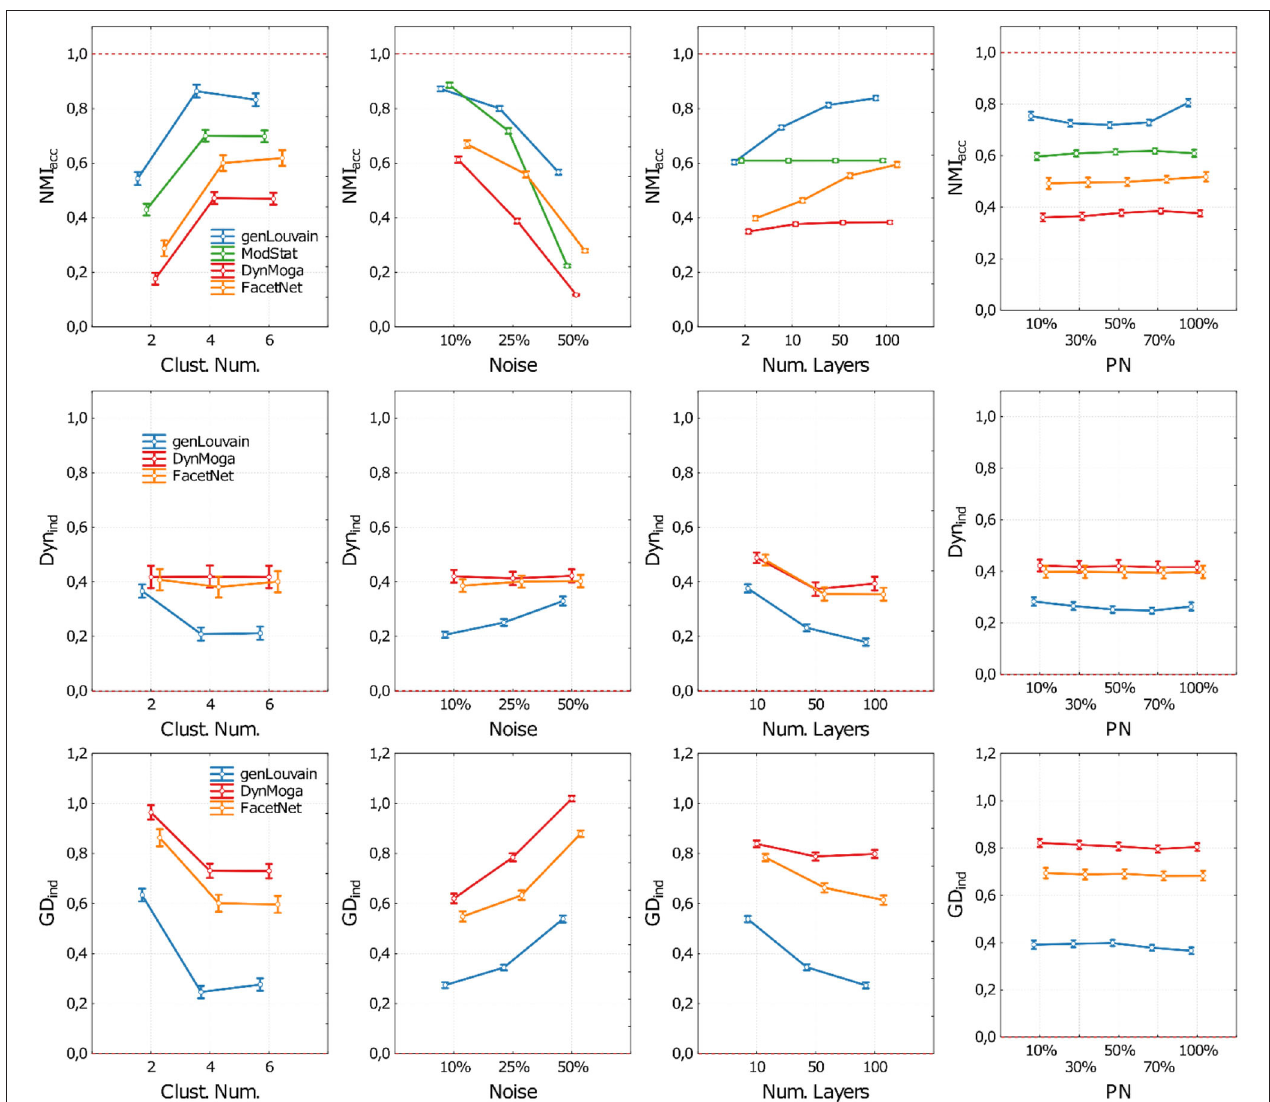
FIGURE 4 | Plot of means and standard deviations of the three indices used to execute the comparative analysis on networks with evolving community structure. Each row of the figure corresponds to one index (NMI acc , Dyn ind , and GD ind ). For each index, we report four panels where we show the algorithms’ performances with respect to the cluster number (first column), noise level (second column), number of network’s layer (third column), and percentage of nodes changing module (fourth column). Algorithms are identified through a color code (blue—genLouvain, green—ModStat, red—DynMoga, orange—FacetNet). In each panel, we can see how the performance of the algorithms varies according to the values of the ANOVA factors and which algorithm reaches highest performances in terms of accuracy (NMI acc ), stability (Dyn ind ), or both (GD ind ). The optimal performances are indicated though a red dotted